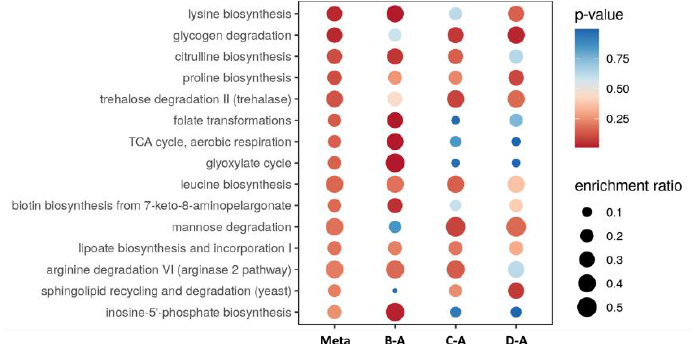
Figure 3. Metabolic profiles of the fungus grown in substrates B–D with respect to substrate A taken as reference. In the figure, red color indicates higher probability of metabolic pathway activation, whereas the blue color suggests a minor one.